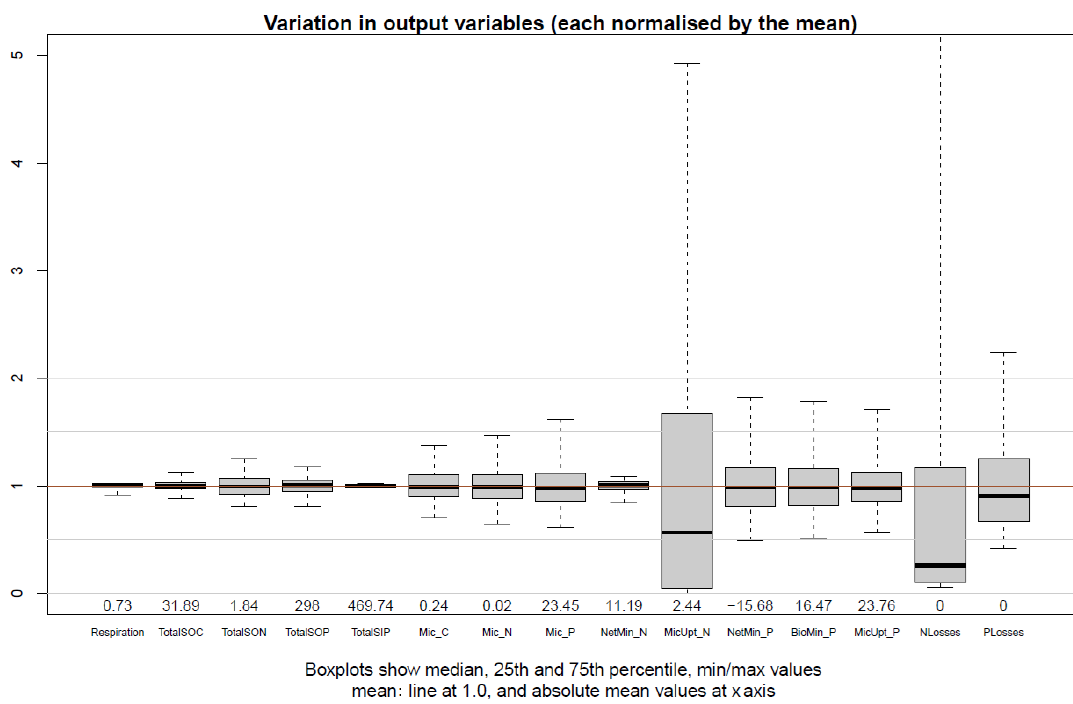
Figure 10. Normalised output variations in the LHS sensitivity analysis. The selected output variables include respiration; total soil organic C, N and P; microbial C, N and P; net N mineralisation; microbial N uptake; net P mineralisation; biomineralisation of P; microbial P uptake and N and P losses. All the calculations are performed for the topmost 1m of soil based on data from the last 10 years of 1000LHS